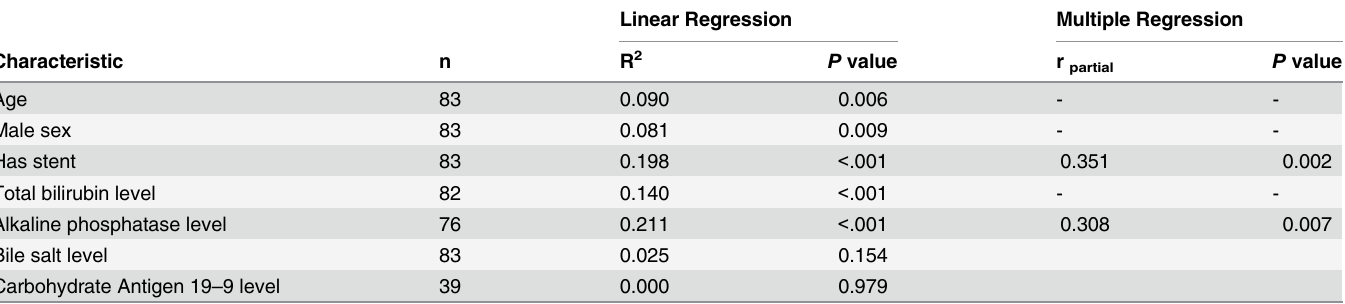
Table 5. Regression analyses of clinicopathologic variables potentially associated with CEACAM6